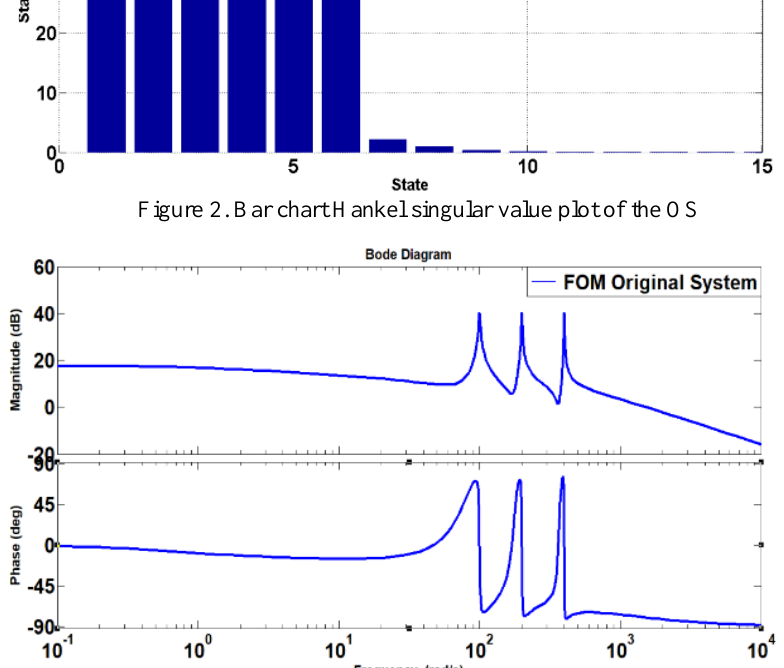
Figure 3. Frequency response of the